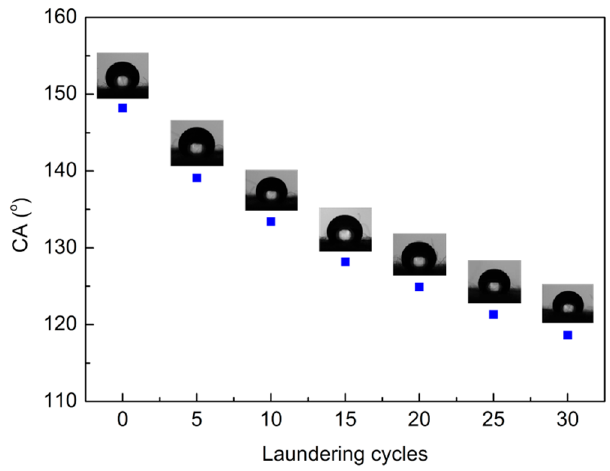
Figure 9. Contact angle (CA) of water drop on the cotton fabrics.